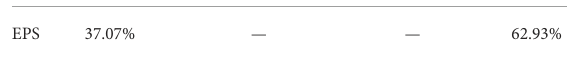
TABLE 3 The content of protein secondary structure of strain